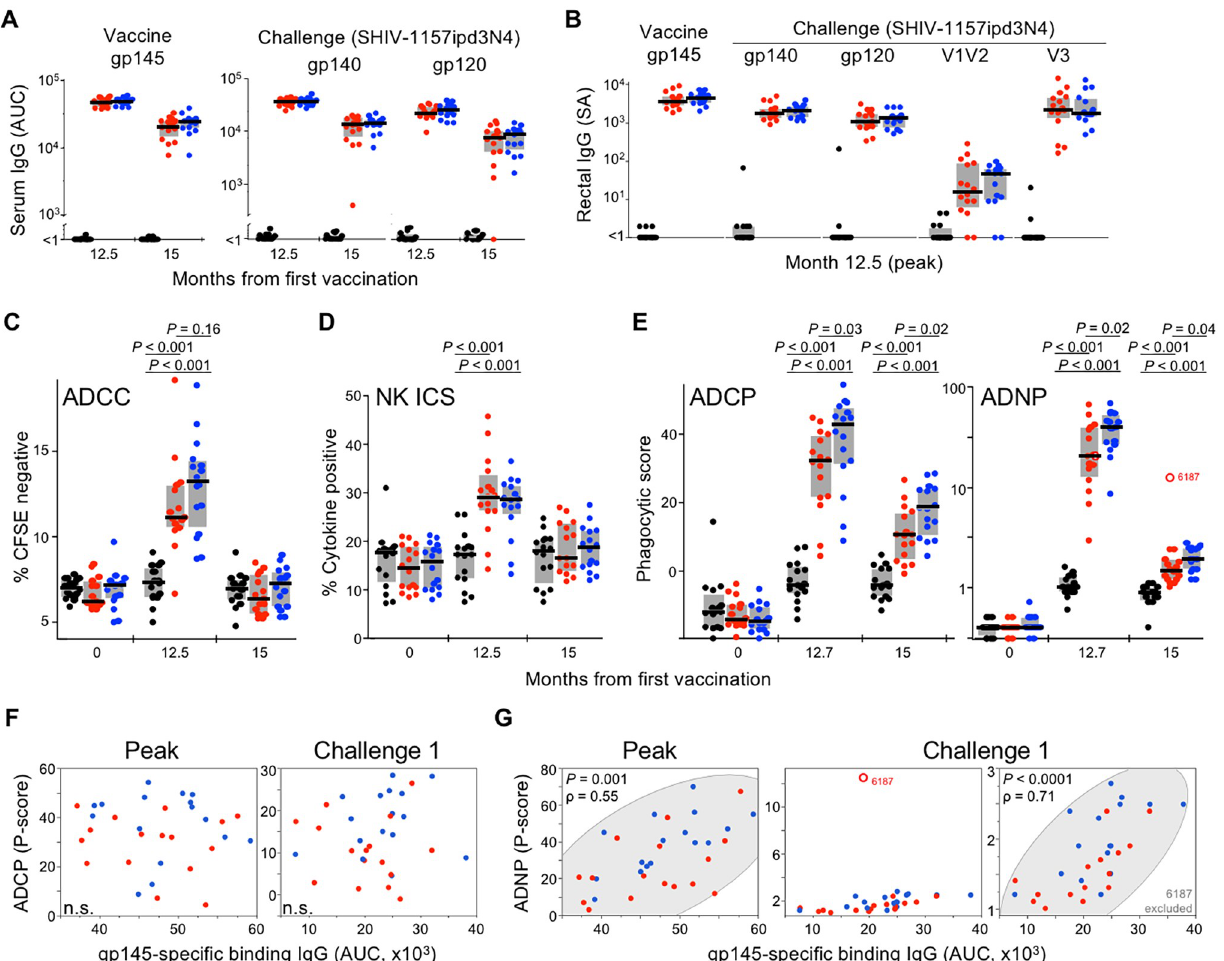
Fig 2. Env-specific antibody binding and effector responses elicited by vaccination. (A) Serum IgG binding antibody responses to gp145 and SHIV- 1157ipd3N4 antigens are shown at peak and time of challenge. Area under the curve (AUC) reflects BAMA MFI values across serially diluted serum. (B) Peak rectal binding IgG responses reported as specific activity (SA), calculated as MFI � dilution / IgG concentration. All active arm responses in (A-B) are significantly different from the control arm, but not from each other. (C) Longitudinal serum ADCC responses were assessed by antibody-dependent lysis of CFSE-labeled Env-coated target cells and are reported as an increase in CFSE-negative target cells. (D) Antibody-dependent NK cell responses were measured by Env stimulation in the presence of animal sera followed by intracellular cytokine staining (ICS) for IFN γ , TNF α , and MIP1 β . The frequency of NK cells expressing one or more cytokine Boolean combinations is shown. (E) ADCP and ADNP responses were assessed using THP-1 monocyte and human neutrophil effectors, respectively. ADNP open symbol depicts animal that resisted three additional high-dose challenges. Effector assays were performed with CO6980v0c22 multimeric gp145. For ADCP and ADNP, serum was used at month 0 and plasma at months 12.7 and 15 due to sample availability. Gray bars reflect interquartile range; black lines depict medians; P values in (C-E) reflect Wilcoxon rank-sum test. (F-G) Spearman correlation between ADCP and ADNP responses and serum gp145-specific binding antibodies at indicated time points. Symbol colors reflect control (black), alum (red), and ALFA (blue) groups.